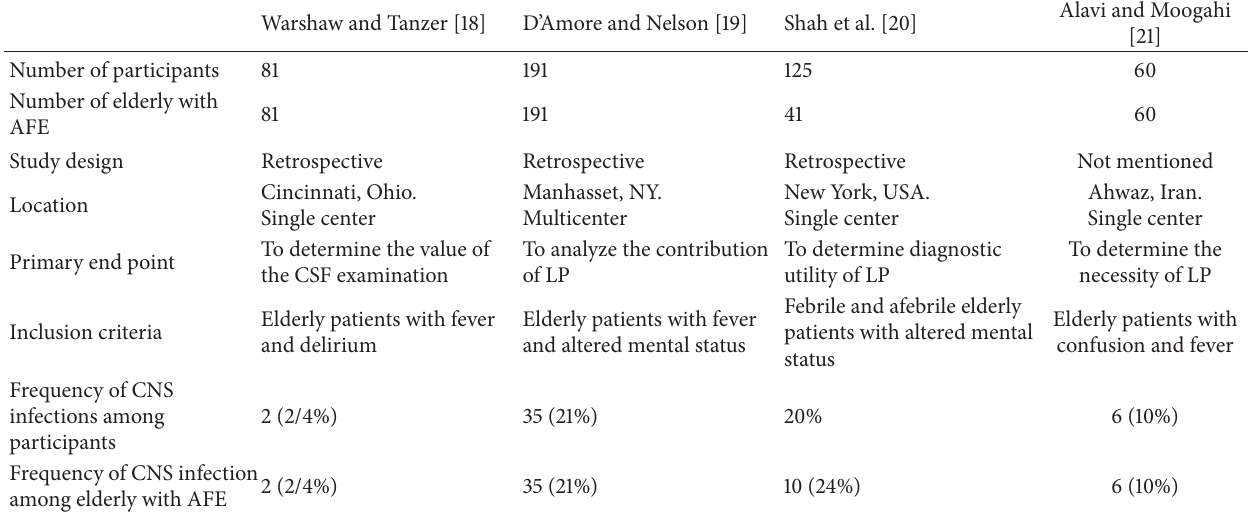
Table 1: Summary of the analyzed studies about the frequency of CNS infection in elderly patients with